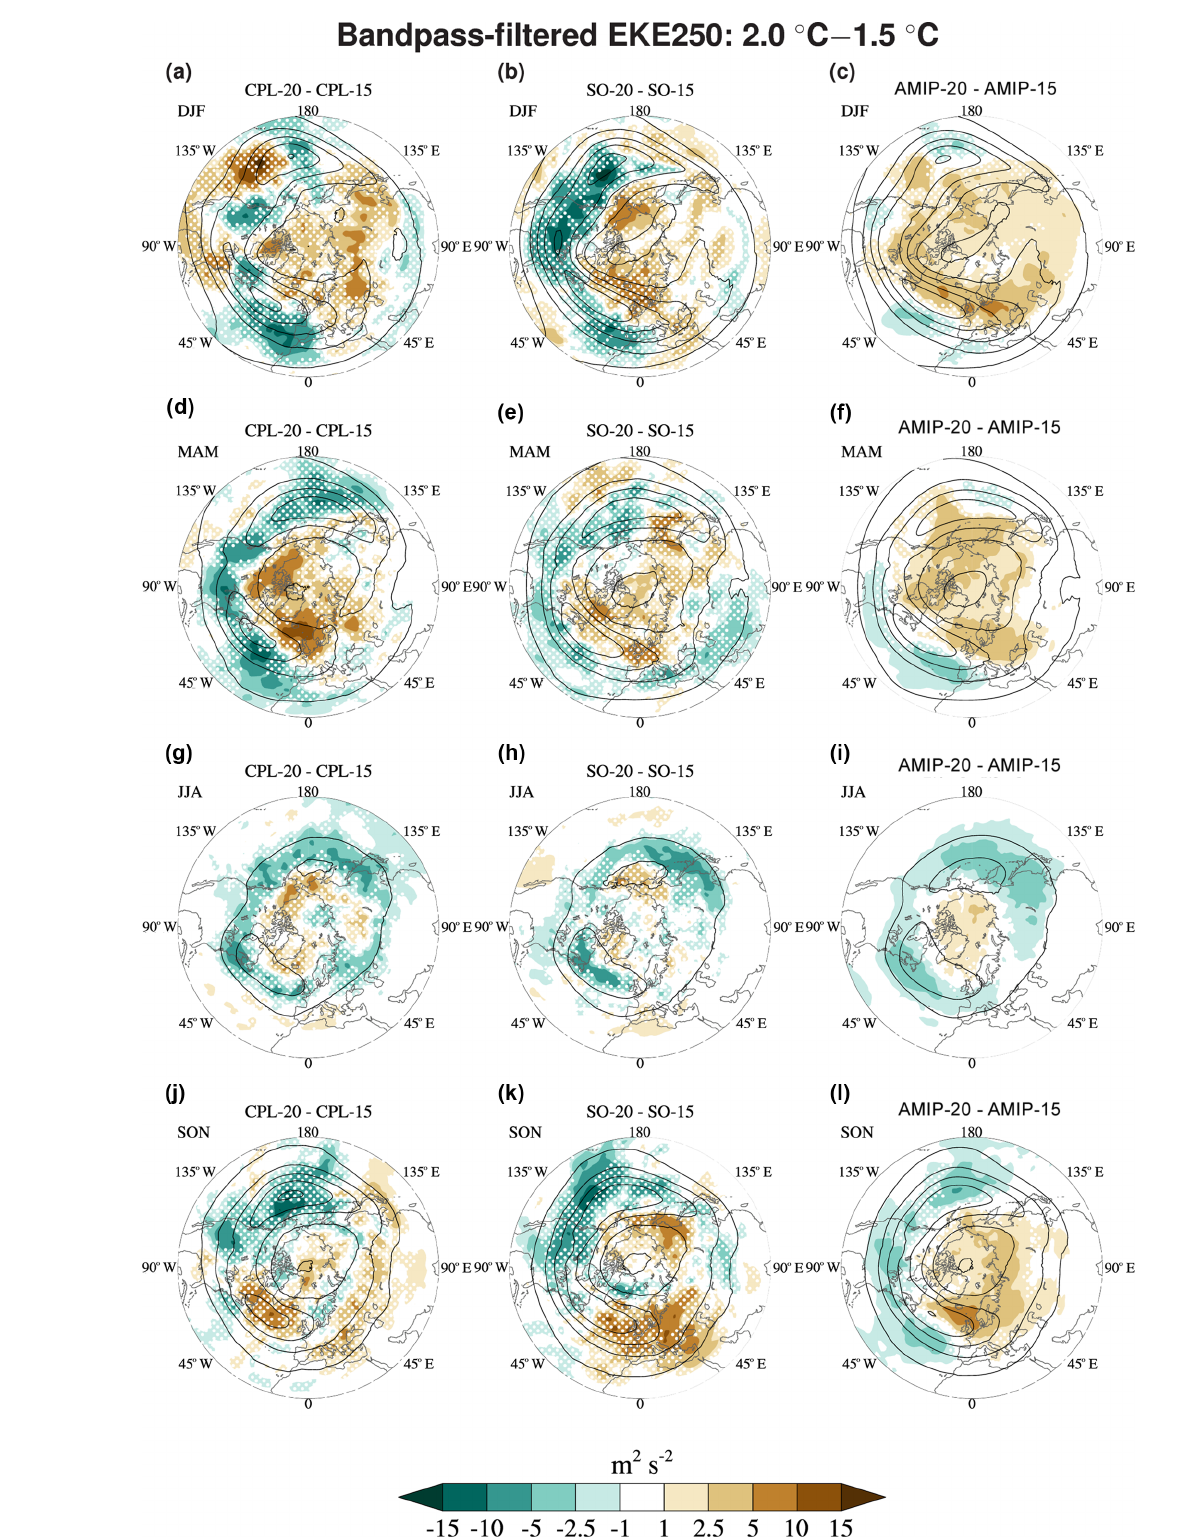
Figure 14. As in Fig. 13 but for the upper-level storm-track response to the additional 0.5 ◦ C warming (i.e. the difference between the respective 2.0 and 1.5 ◦ C